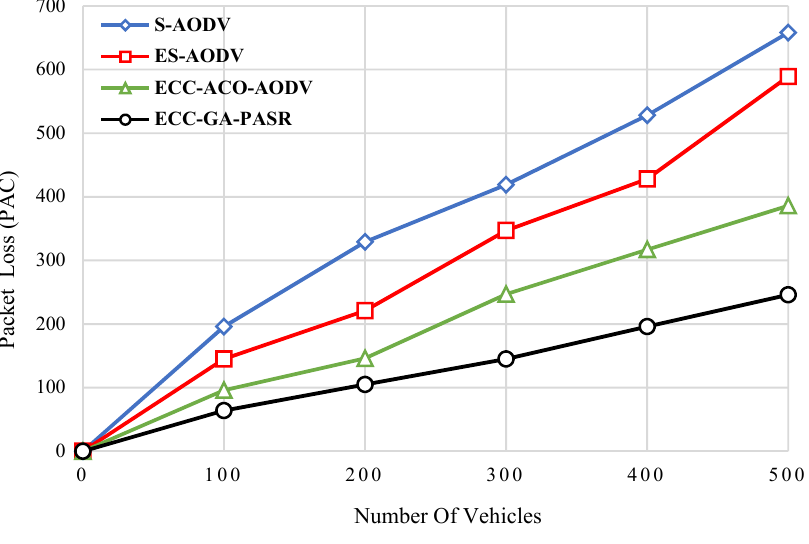
Figure 12. Packet Loss Calculation based on number of vehicles.